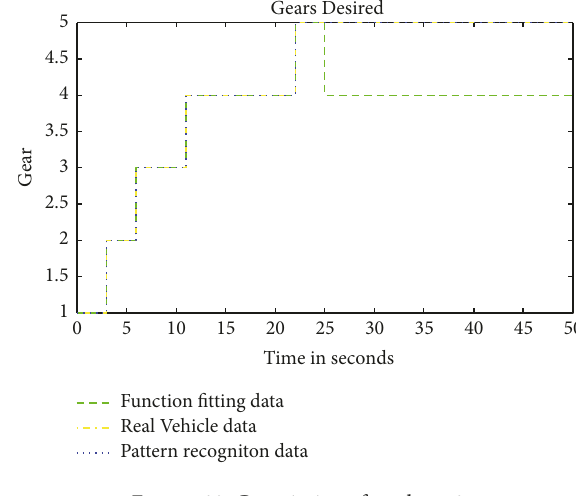
Figure 22: Gear timing of road test 2.